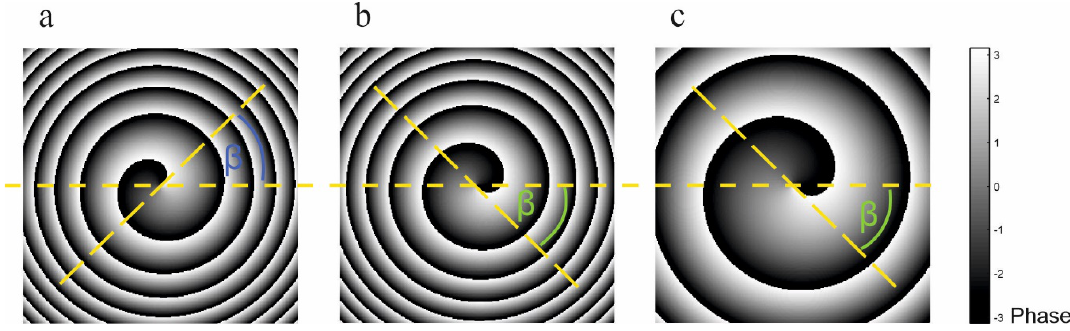
Figure 2. Phase distribution obtained by using Equation (2 ) for m = 1 and different values of α and β . ( a ) α = 13.9 (1/mm 2 ) and β = 0.77; ( b ) α = 13.9 (1/mm 2 ) and β = − 0.79; ( c ) α = 5.26 (1/mm 2 ) and β = − 0.79.